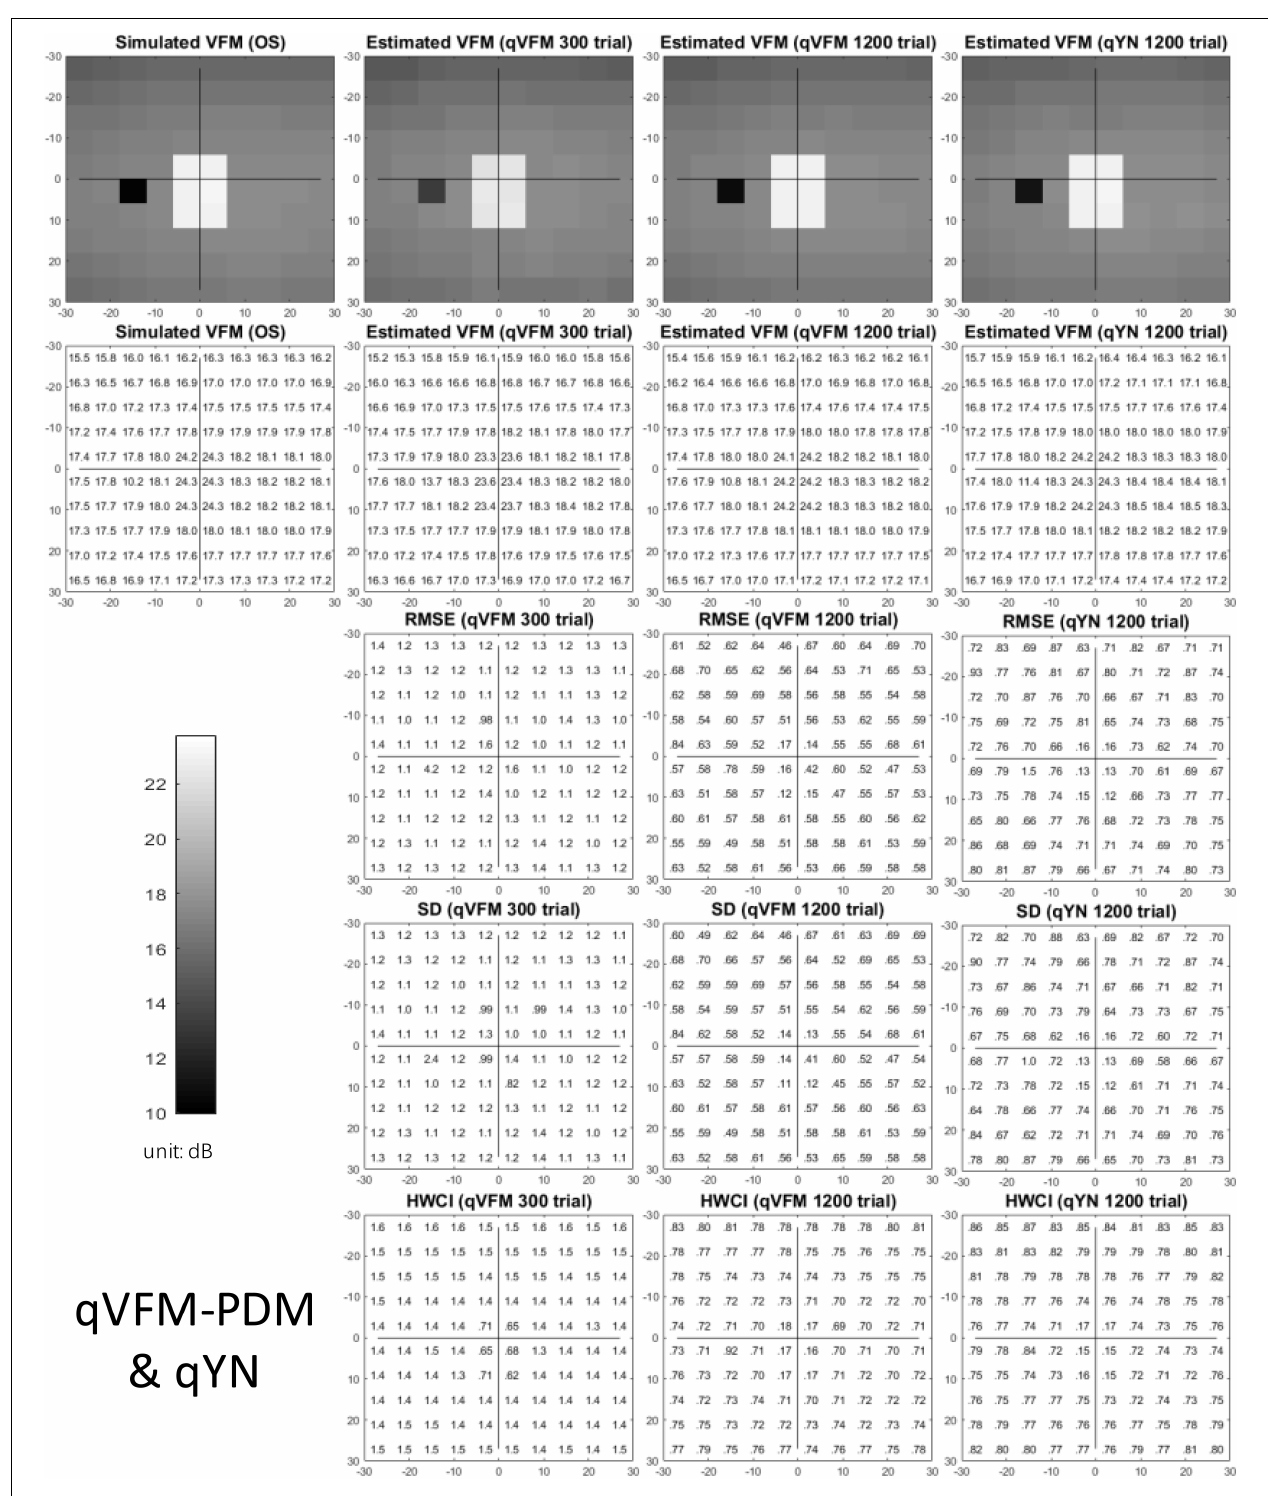
FIGURE 5 | Simulation results I of the glaucoma observer across 200 runs. The true VFM of the simulated observer (monocular) is presented in the first column of the first row with achromatic colormaps and second row with numerical values. The estimated VFMs obtained with the qVFM-PDM method after 300 trials and 1,200 trials, qYN method after 1,200 trials are presented in the first and second rows, respectively. The corresponding RMSE, SD, and 68.2% HWCI of the estimates are shown in the third, fourth, and fifth rows.